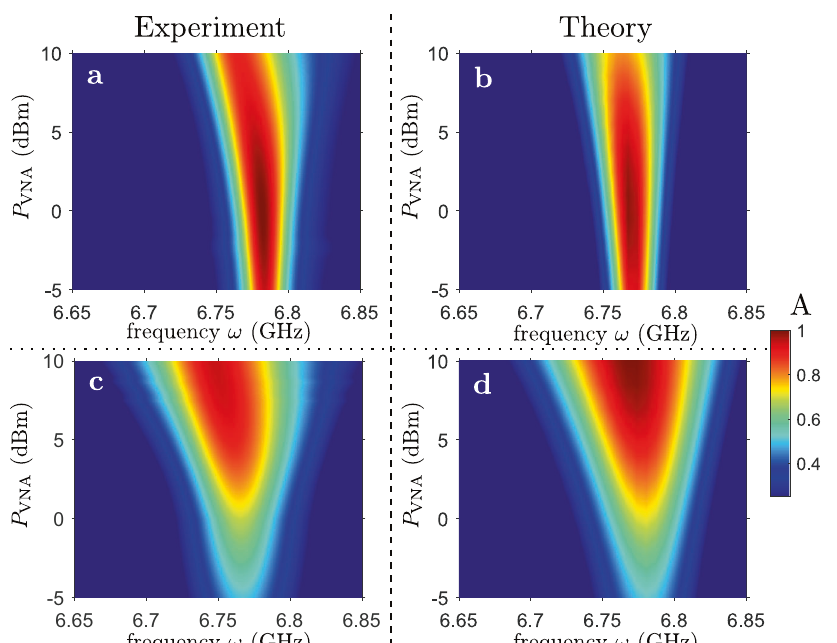
Fig. 2 Absorbance A as a function of frequency ω and the injected power P VNA . In a the experimentally measured absorption for two weakly coupled antennas with coupling strength, κ 0 = 0.23 GHz is shown. b shows the corresponding result of our modeling equation (1) with non-linear complex frequency shift Ω given by equation (2). The experimental maximal absorbance is A = 99.99% occuring at P NLCPA = 0 dBm, ω NLCPA ≈ 6.782 GHz. The theoretical NLPCA ’ s gives A = 1, at P NLCPA = − 0.486 dBm, ω NLCPA = 6.769 GHz. The results for two moderately coupled antennas ( κ 0 = 0.4 GHz) for the experiment ( c ) and the model ( d ) are shown. The experimental maximum absorbance is A ≈ 95% occurring at P NLCPA = 9.8 dBm, ω NLCPA = 6.747 GHz. The theoretical non-linear perfect coherent absorber (NLPCA) with A = 1, occurs at P NLCPA = 10.23dBm, ω NLCPA =